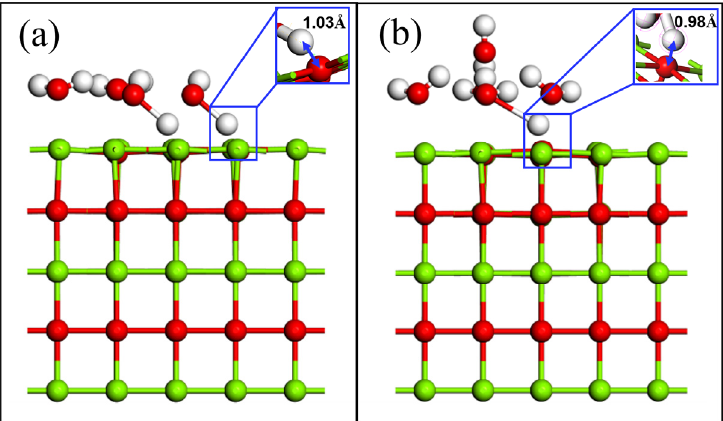
Figure 5. The surface adsorption of multi molecule water: ( a ) coverage is 1; ( b ) coverage is 1.25.